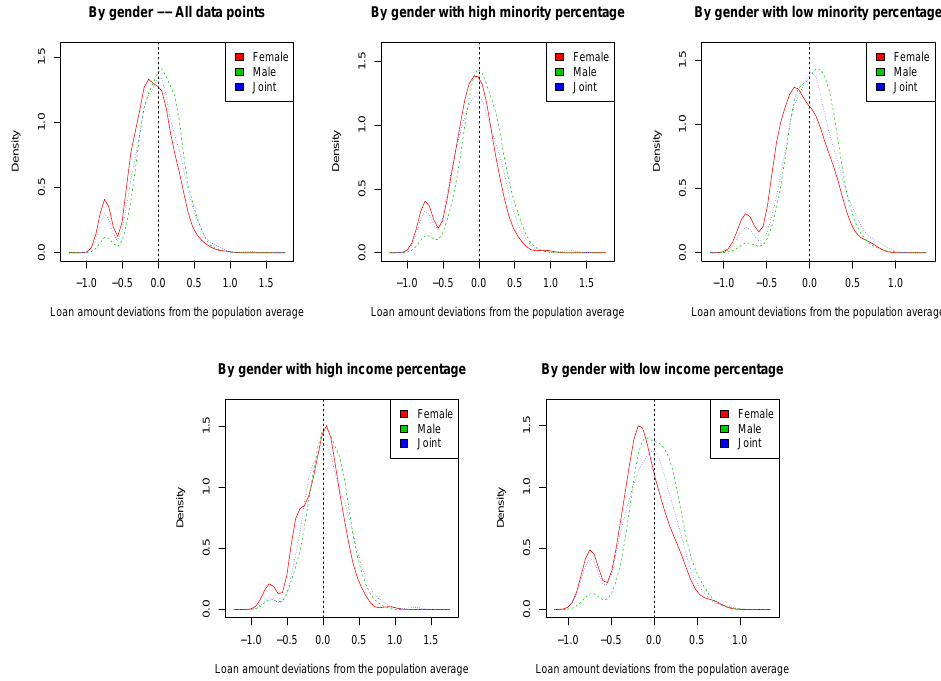
Figure 3. VT loan amount deviations from the population mean based on full data and sub-populations with low/high minority and low/high income